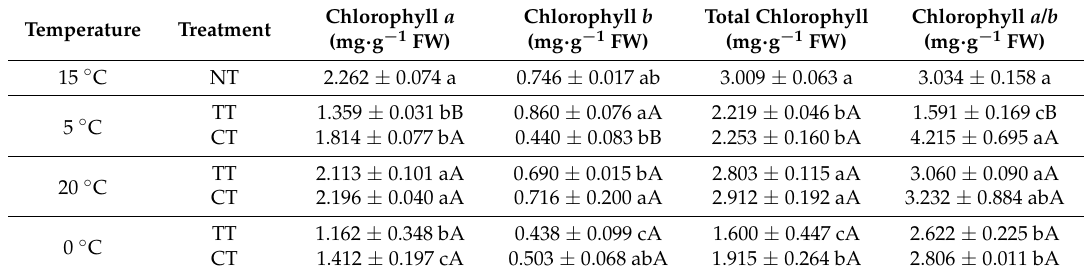
Table 1. Effect of calcium on the contents of pigments in M. baccata leaves under temperature stress.